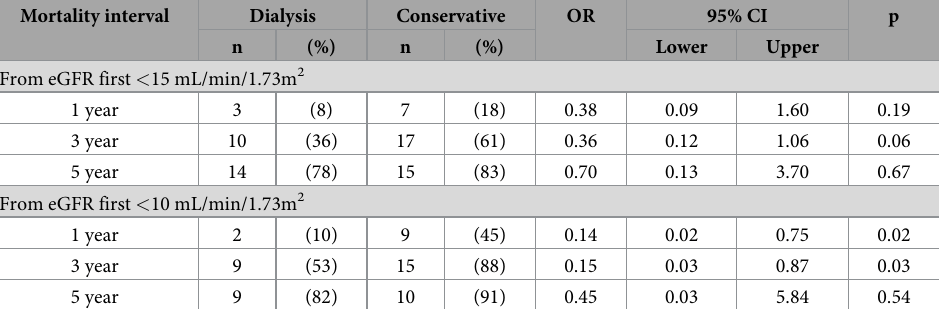
Table 2. Comparison of survival between patients who chose dialysis versus those who chose conservative care, patients being matched 1:1 by propensity scores. Mortality interval Dialysis Conservative OR 95% CI p n (%) n (%) Lower Upper From eGFR first < 15 mL/min/1.73m 2